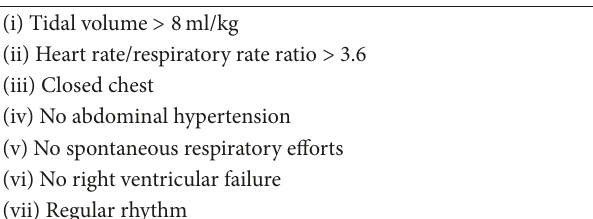
Table 1: Prerequisites for dynamic preload assessment using venti- lation-induced hemodynamic